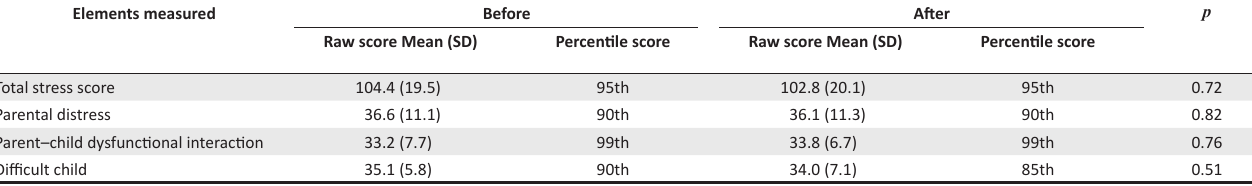
TABLE 3: Parenting stress index-short form results. Elements